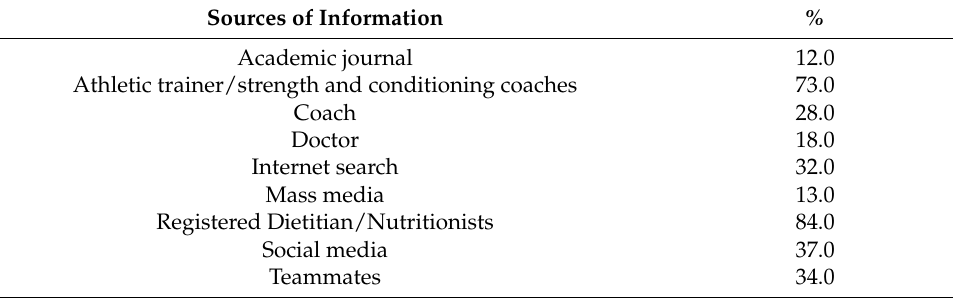
Table 4. Participants sources of